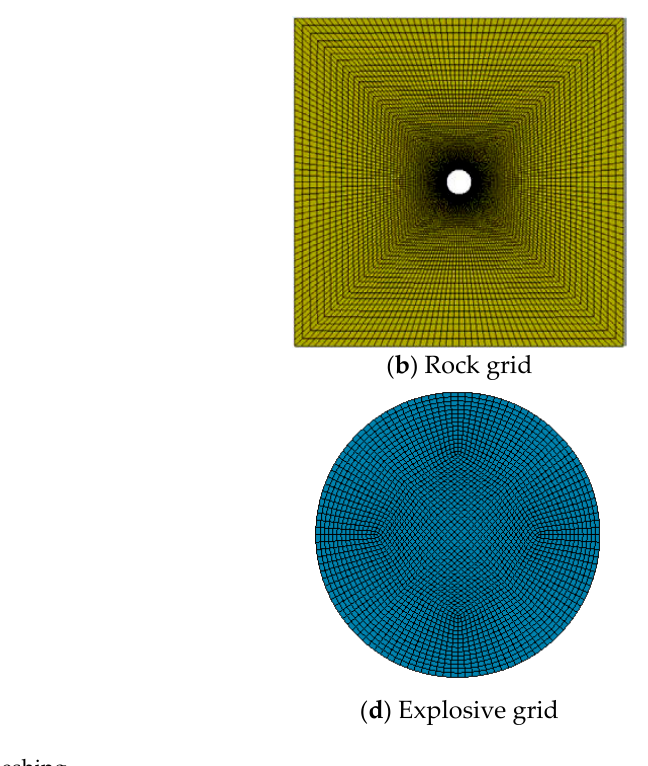
Figure 17. Model meshing.